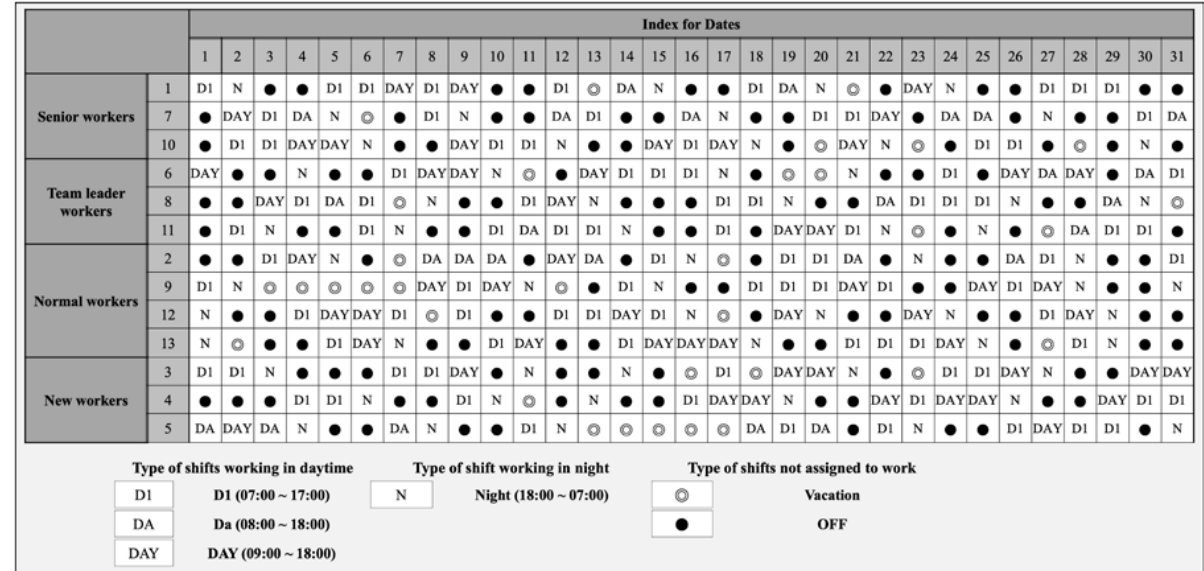
Figure 4. Optimal staff schedule using mathematical model.